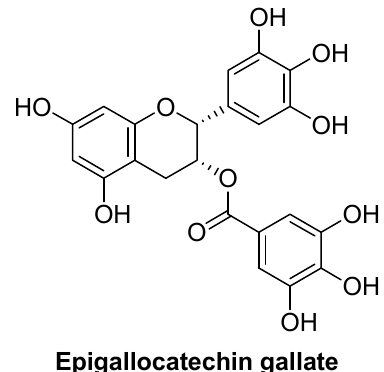
Figure 44. Epigallocatechin gallate.